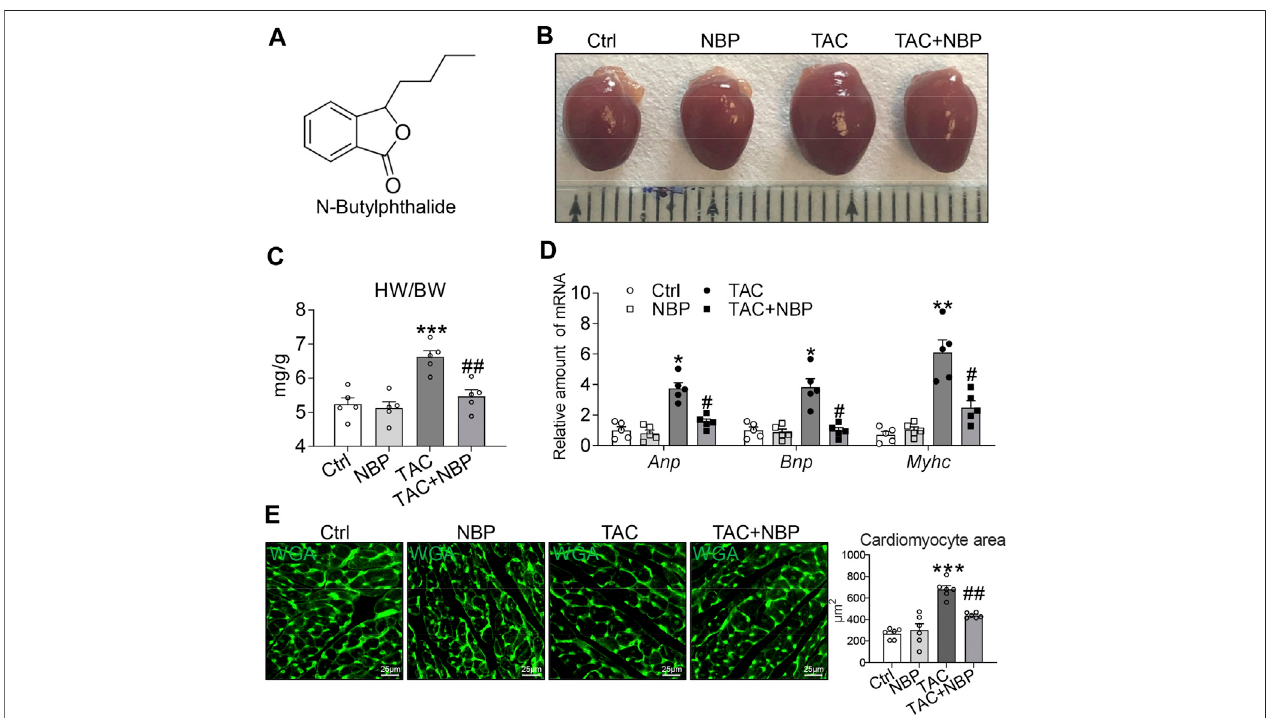
FIGURE 1 | NBP prevents TAC-induced myocardial hypertrophy in vivo . (A) Chemical structure of NBP. (B) Representative gross heart tissues showing the effect of NBP on TAC-induced structural de fi cits. (C) Ratio of the heart weight to body weight (HW/BW). (D) mRNA levels of hypertrophy markers Myhc, Anp, and Bnp. (E) Representative WGA staining of heart tissues showing the effect of NBP on TAC-induced hypertrophic responses. Quantitative analysis of the cardiomyocyte area is shown in the right panel. (n (cid:1) 5 in each group; *, vs. Ctrl group; #, vs. TAC group; * and # p < 0.05, ** and ## p < 0.01, *** p < 0.001).